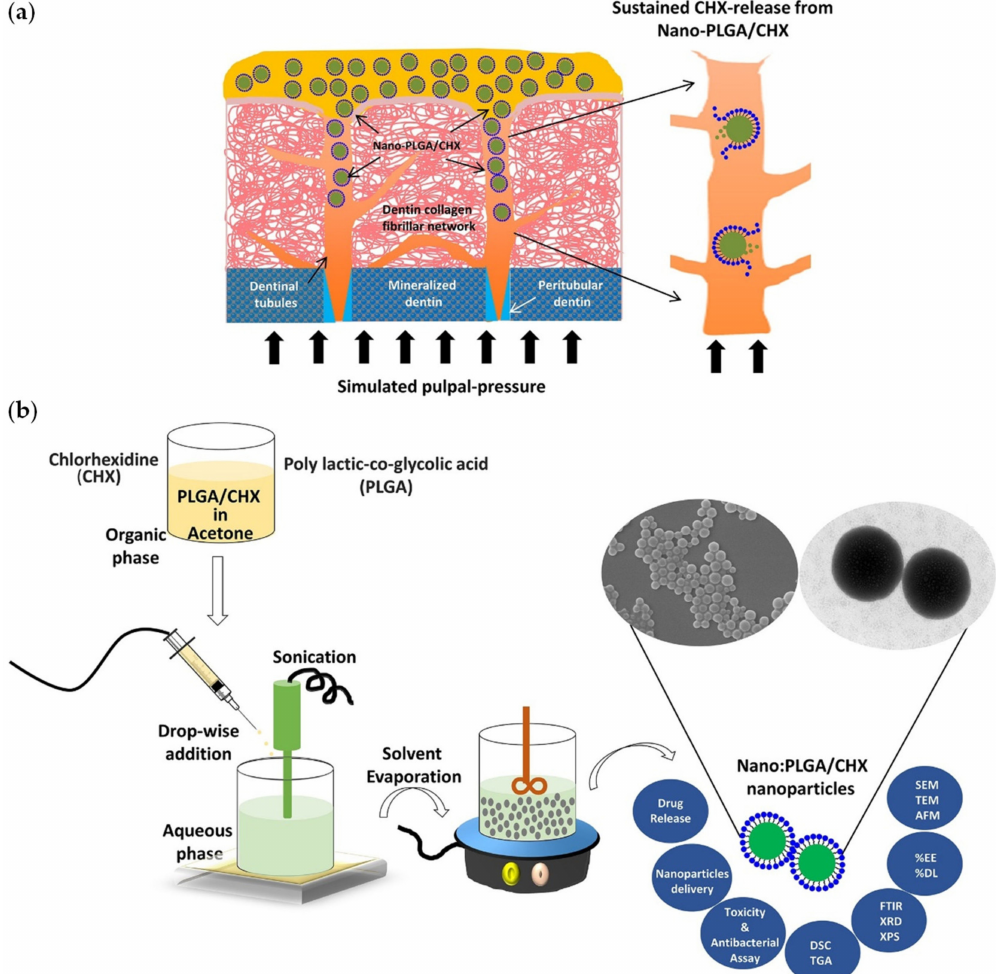
Figure 3. ( a ) Schematic diagram showing the proposed principle of delivering the active drug (CHX) to the demineralised dentin-substrates in the form of CHX-loaded PLGA NPs through the micron-sized dentinal-tubules (DT) under the influence of the simulated pulpal-pressure targeting for prolonged drug-release and retention inside the collagen fibers of demineralised dentin matrix. NPs should act as a repository that slowly degrades to provide a constant source for the release of CHX over predetermined time-intervals. The retained NPs inside the dentinal-tubules will slowly release CHX to be carried by the dentinal-fluids present in the dentinal-tubules under the influence of the positive intra pulpal hydrostatic pressure through the 3D interconnected tubular capillary platform and the water-rich interfibrillar spaces of the dentin-collagen network. ( b ) Illustrative sketch showing the preparation of the CHX-loaded PLGA NPs by the emulsion evaporation procedure and their subsequent characterisation, including representative SEM and TEM micrographs. Adapted with permission from Pryiadarshini et al.